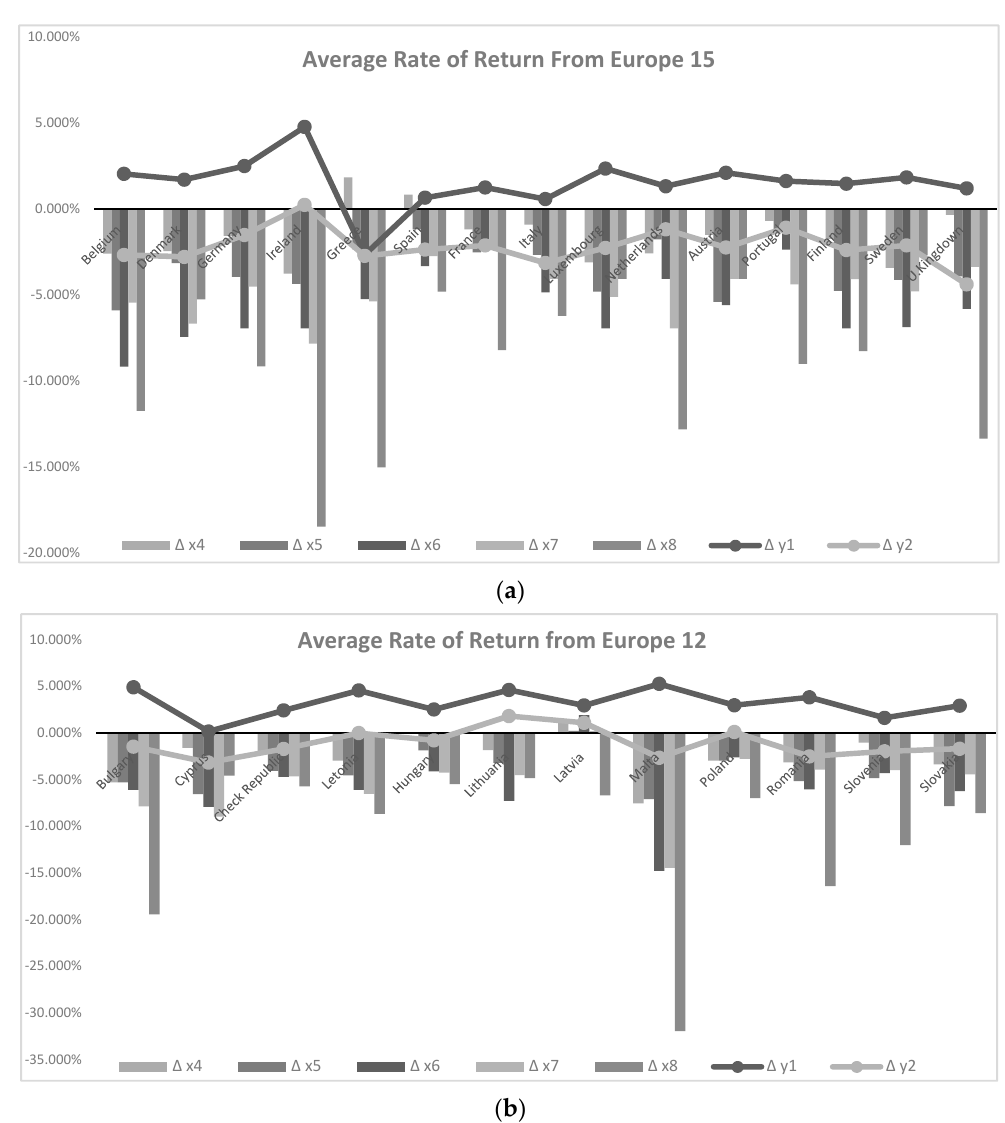
Figure 2. Evolution of the profitability rate of polluting gases (x4, x5, x6, x7, x8 stand for ammonia (NH 3 ), nonmethane volatile organic compounds (NMVOC), particles with a diameter of less than 2.5 µm (PM2.5), particles with a diameter of less than 10 µm (PM10), SO X , respectively) in opposition to the evolution of the rate of return of the indicator of economic growth per capita (y1) and the rate of return of GHG (y2) for each country: ( a ) average rate of return from EU 15; ( b ) average rate of return from EU 12 (2008–2018 period).